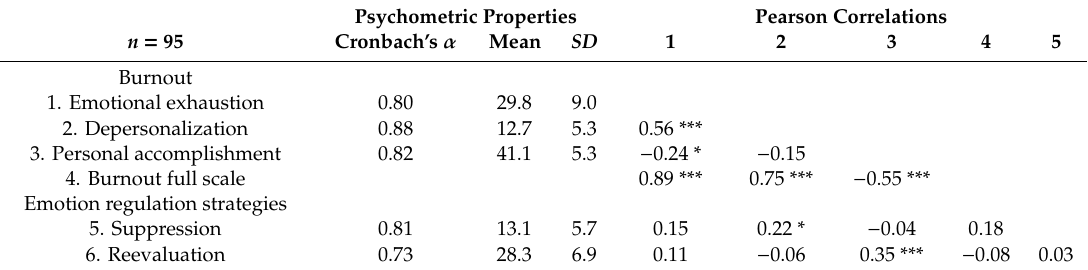
Table 3. Psychometric properties and Pearson correlations between burnout and cognitive